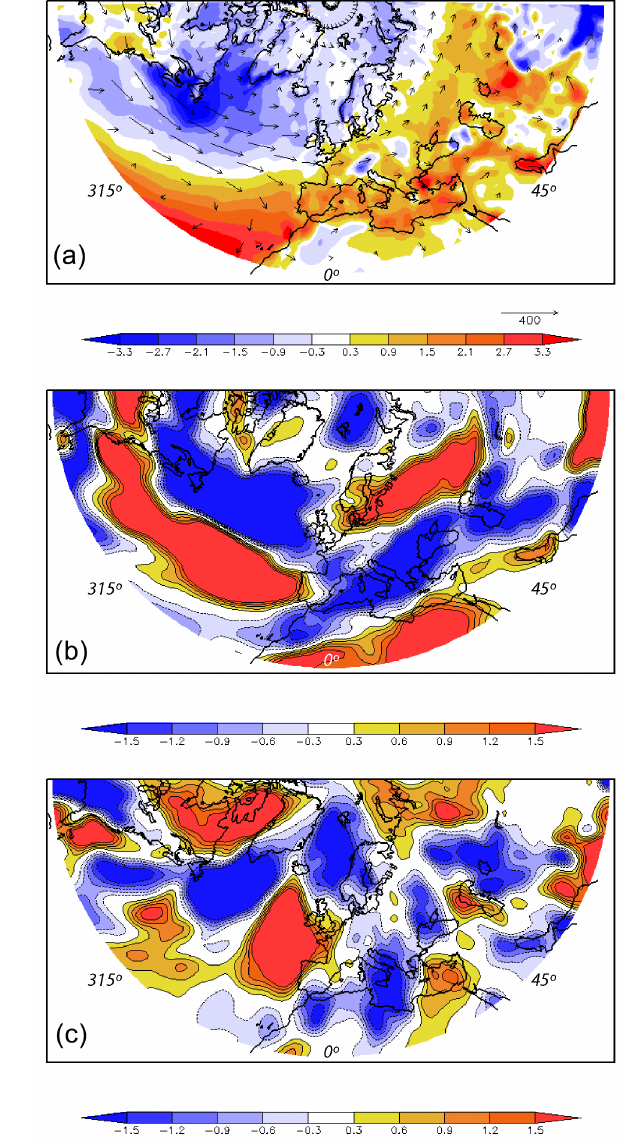
Figure 10. (a) The climatological vertical integrated moisture flux (VIMF) (vector, kgm − 1 s − 1 ) and its divergence (shaded, mmyr − 1 ) in June for the European sector, (b) the difference between the pe- riods after vs. before the CP for the zonal component of VIMF, and (c) as for panel (b) but for the meridional component of VIMF.